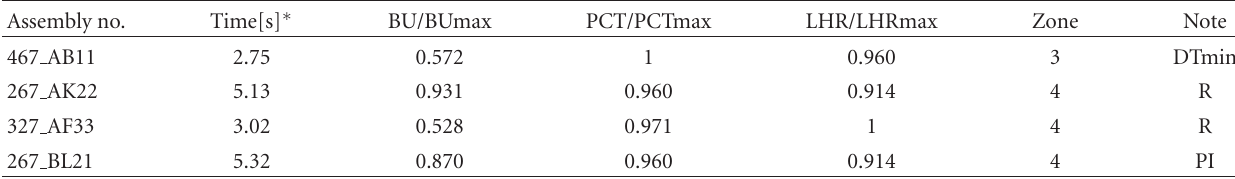
Table 2: Failed rods, case of equilibrium burnup of the reference